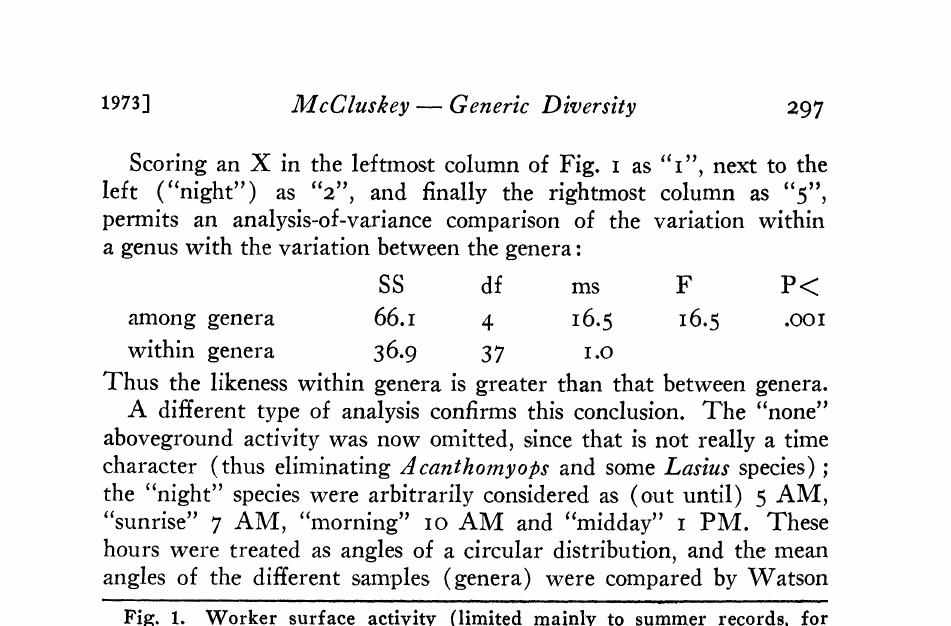
Fig. 1. Worker surface activity (limited mainly to summer records, for most direct comparison of species). Each X represents one species and shows its nearest approach to midday; those based on the most limited cited records are enclosed in (). The leftmost column "NONE" indicates that the species do.es not usually come above ground at all. Following are species and literature sources represented: FORMICA: bradleyi